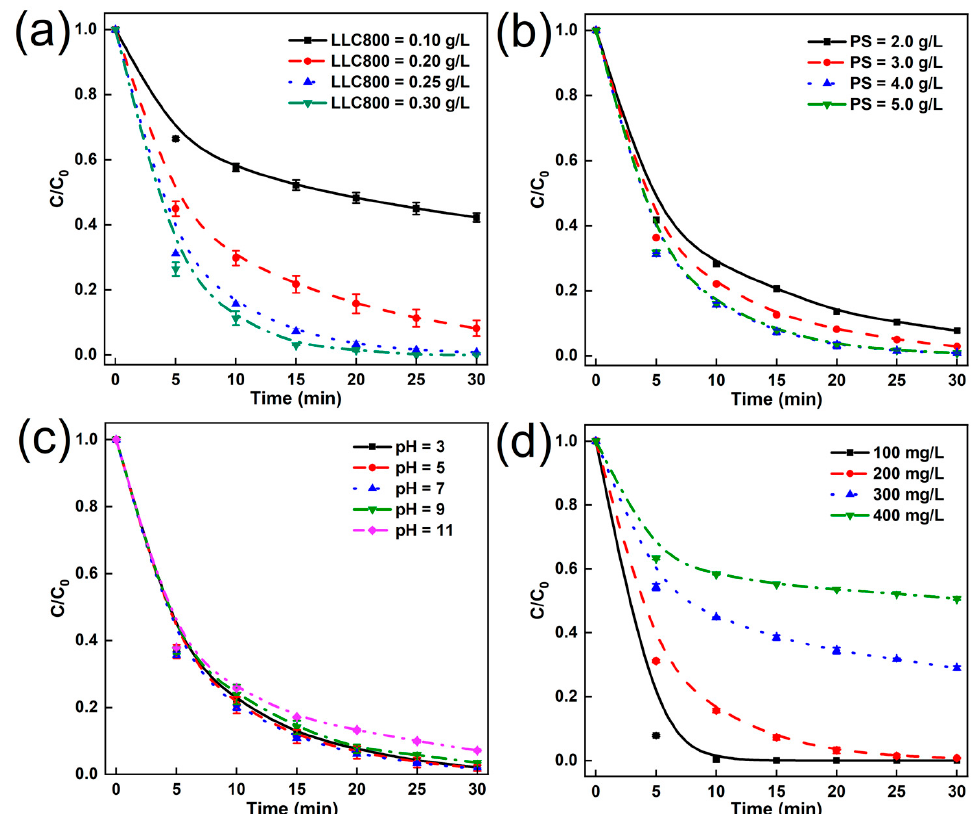
Figure 6. Effects of LLC ( a ) and PS ( b ) dosing, pH ( c ) and initial concentration of AO7 ( d ) on the degradation efficiency of